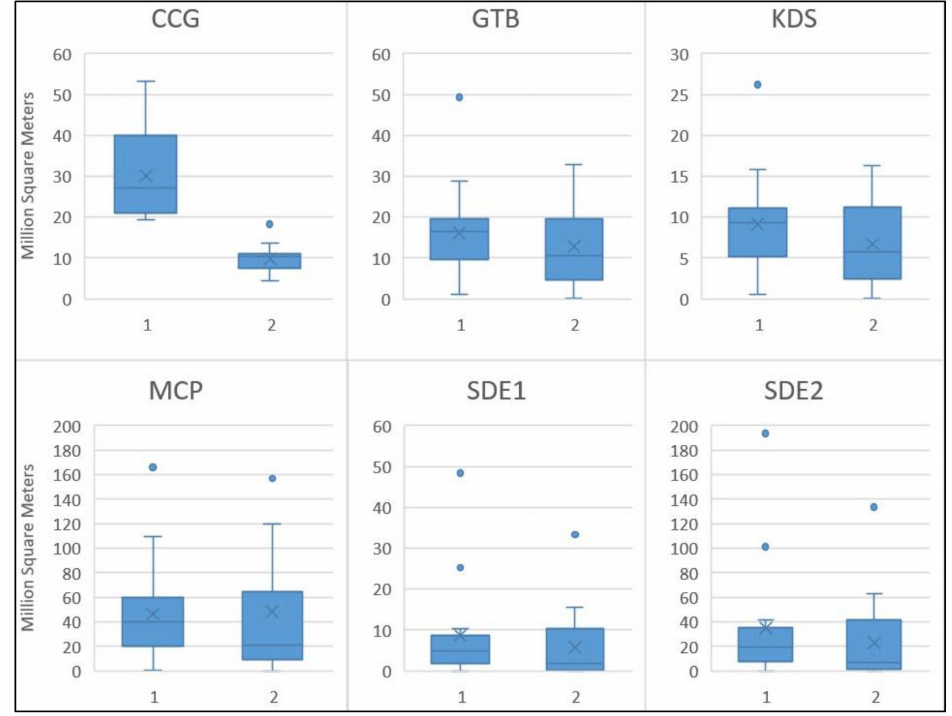
Figure 10. The differences in size of activity space for private transport (1) and public transport users